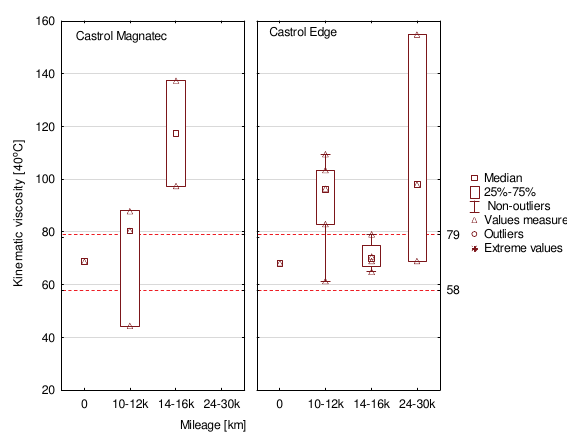
Fig. 1. Kinematic viscosity at 40°C of the engine oils tested